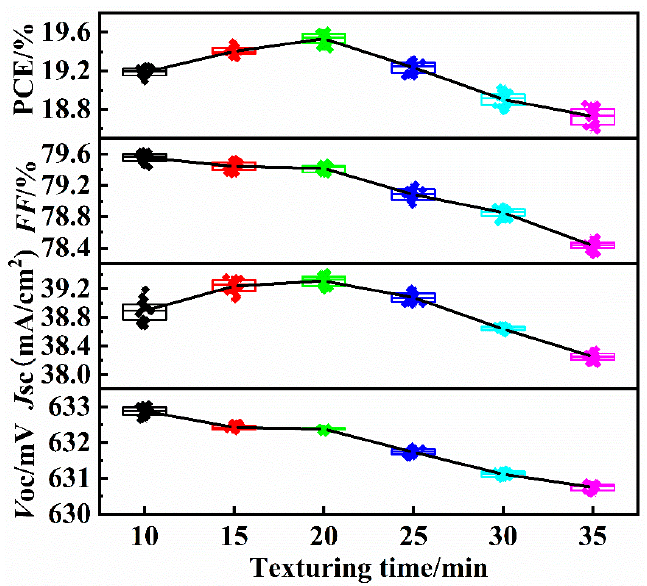
Figure 9. Photoelectric performance of the silicon cells. (with increasing etching time, the open-circuit voltage V OC and fill factor FF gradually decrease, the short-circuit current density J SC and PCE both first increase and then decrease.)